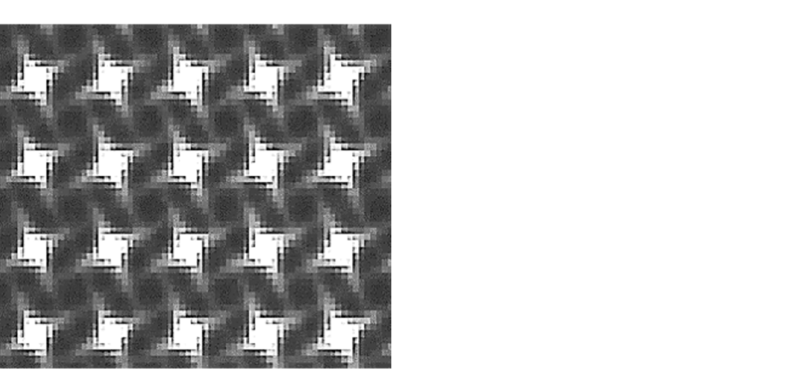
Figure 2. Raw image illustrating the diffraction pattern created by the grid of rotated square holes. At low X-ray energies (high wavelengths), crosstalk is the dominant source of errors,